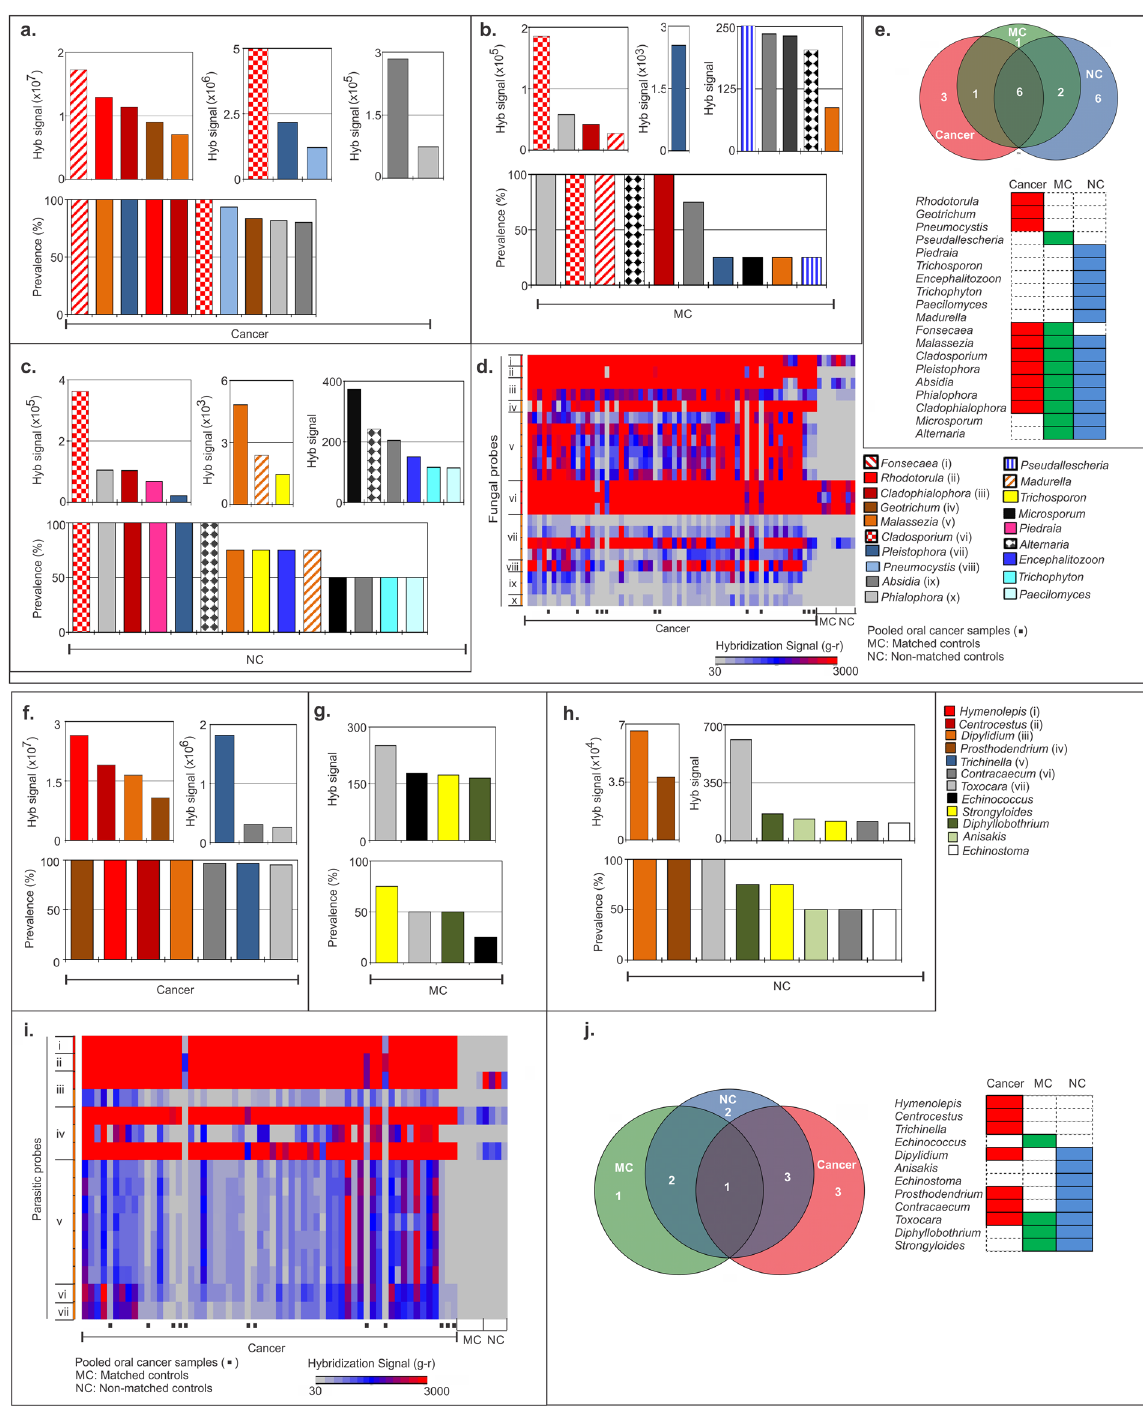
Figure 3. Fungal ( a – e ) and parasitic ( f – j ) signatures detected in oral cancer samples. ( a ) The fungal signatures that are detected with hybridization signal (g–r > 30) by PathoChip screen of 100 oral cancer samples are shown and ranked according to decreasing hybridization signal (weighted score sum of all the probes per accession) and prevalence. ( b and c ) Figure b and c shows the fungal signatures detected in the matched (MC) and non- matched controls (NC) respectively, ranked according to decreasing hybridization signal and prevalence. Figure d shows the heat map of the hybridization signal for the fungal probes of fungi i–x, labeled in figure a , detected by PathoChip screen with the cancer, matched (MC) and non-matched control (NC) samples. Samples were screened individually and in pools (marked ▪ ). ( e ) Figure e shows the association of molecular signatures of different fungal genera with oral cancer and/or controls, represented as a venn diagram, and as colored bars. ( f ) The parasitic signatures that are detected with hybridization signal (g–r > 30) by PathoChip screen of 100 oral cancer samples are shown and ranked according to decreasing hybridization signal (weighted score sum of all the probes per accession) and prevalence. ( g and h ) Figure g and h shows the parasitic signatures detected in